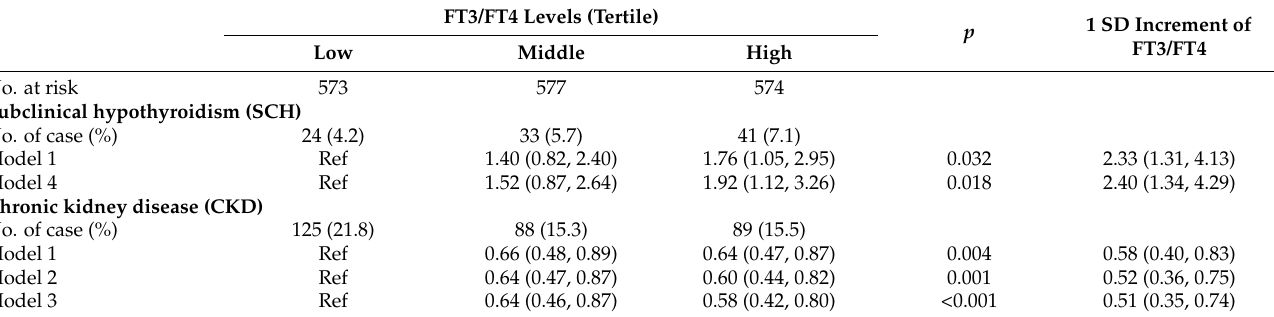
p 1 SD Increment of